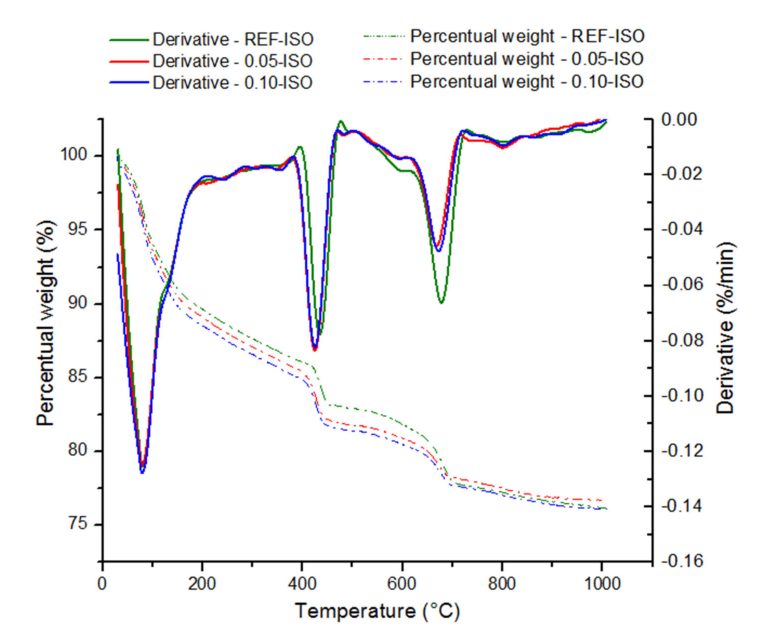
Figure 13. Results of the thermogravimetric